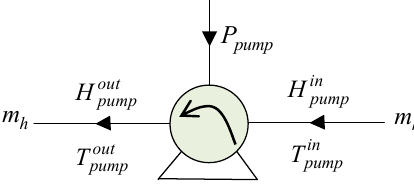
Figure 4. Schematic diagram of circulating pump.